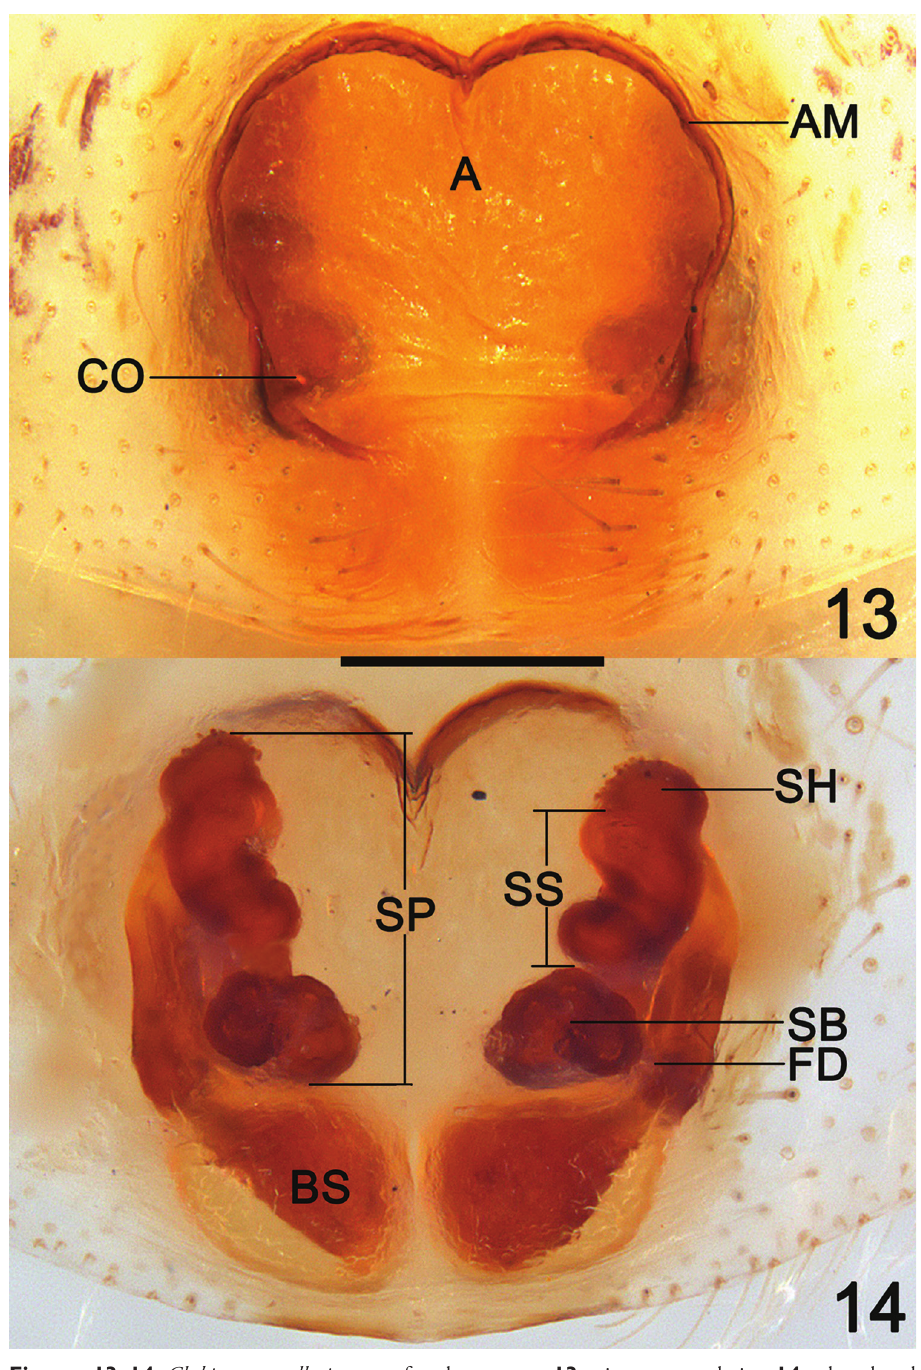
Figures 13–14. Clubiona grucollaris sp. n., female paratype. 13 epigyne, ventral view 14 vulva, dorsal view. Scale bars 0.2